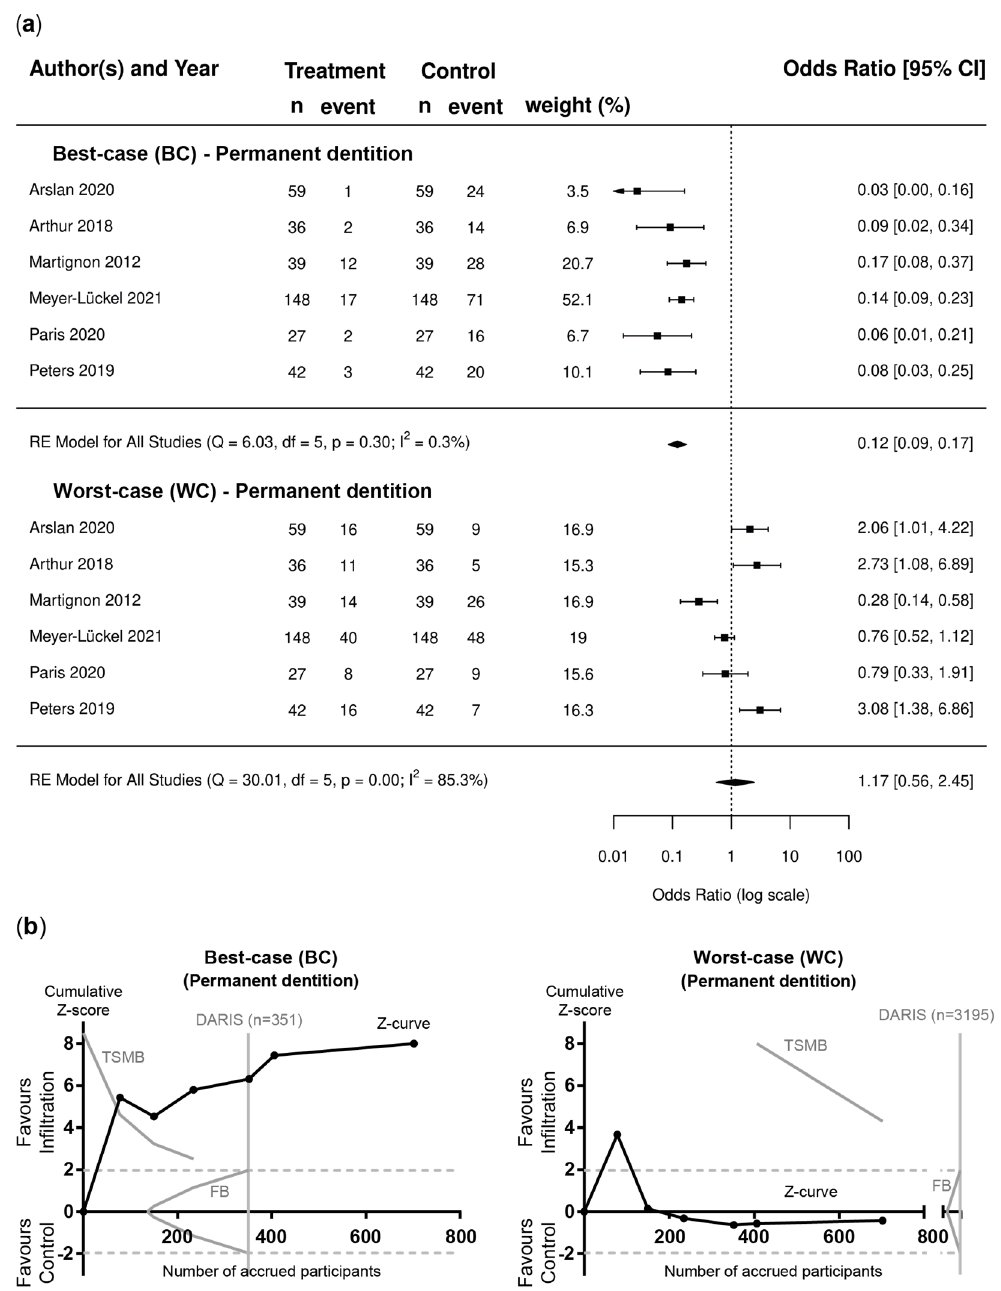
Figure 4. Permanent dentition. ( a ) Forest plots of pairwise meta-analysis for BC and WC scenarios. Risk of failure, i.e., lesion progression, is indicated for lesions in permanent teeth treated with resin infiltration and non-invasive measures compared to placebo and non-invasive measures [57–62]. The odds ratio (OR) and 95% confidence intervals (CI) are shown. Heterogeneity is indicated by I 2 and Q statistics. Diamonds indicate pooled effect estimates. The number of lesions was adjusted using the design effect as described. ( b ) Trial sequential analysis (TSA) of trials evaluating lesions in permanent teeth [57–62] for BC and WC scenarios to assess the robustness of evidence. The cumulative Z-score (black curve), i.e., the accumulated level of significance, was plotted against the number of participants accrued so far, which was compared with the heterogeneity-adjusted required information size (DARIS), the conventional border (Z = 1.96), the trial sequential monitoring boundary (TSMB), and the futility border (FB) (grey oblique). For the BC scenarios the Z-curve crossed the conventional border and TSMB before reaching DARIS, whereas for the WC scenario, the Z-curve failed to cross the conventional border, TSMB, and DARIS.